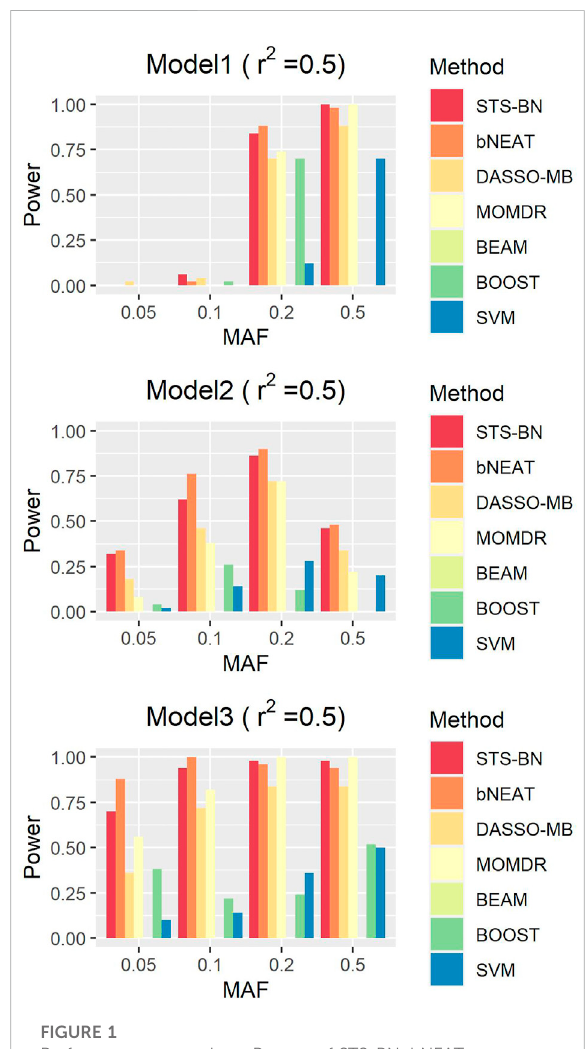
FIGURE 1 Performance comparison. Powers of STS-BN, bNEAT, DASSO-MB, MOMDR, BEAM, BOOST, SVM. (r 2 = 0.5).